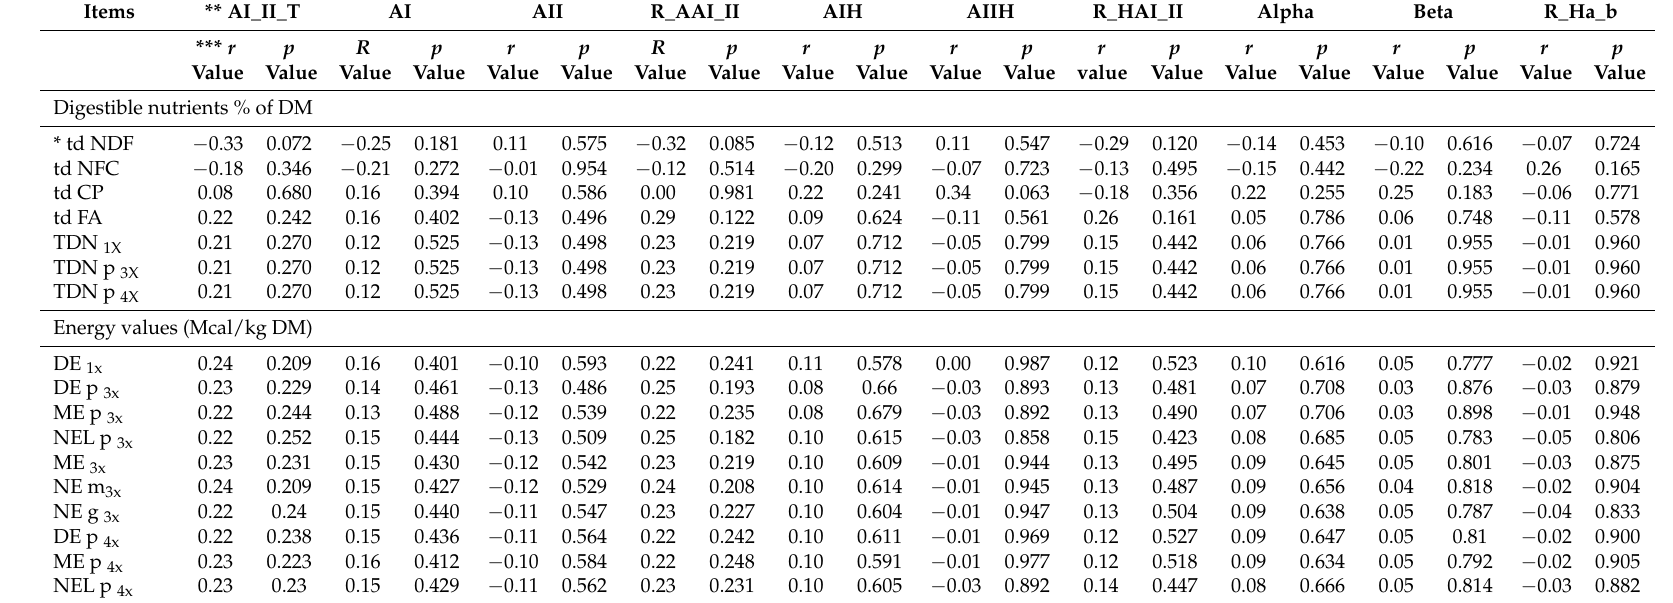
Table 9. Correlation analyses between protein structure spectral characteristics and estimated energy values of canola